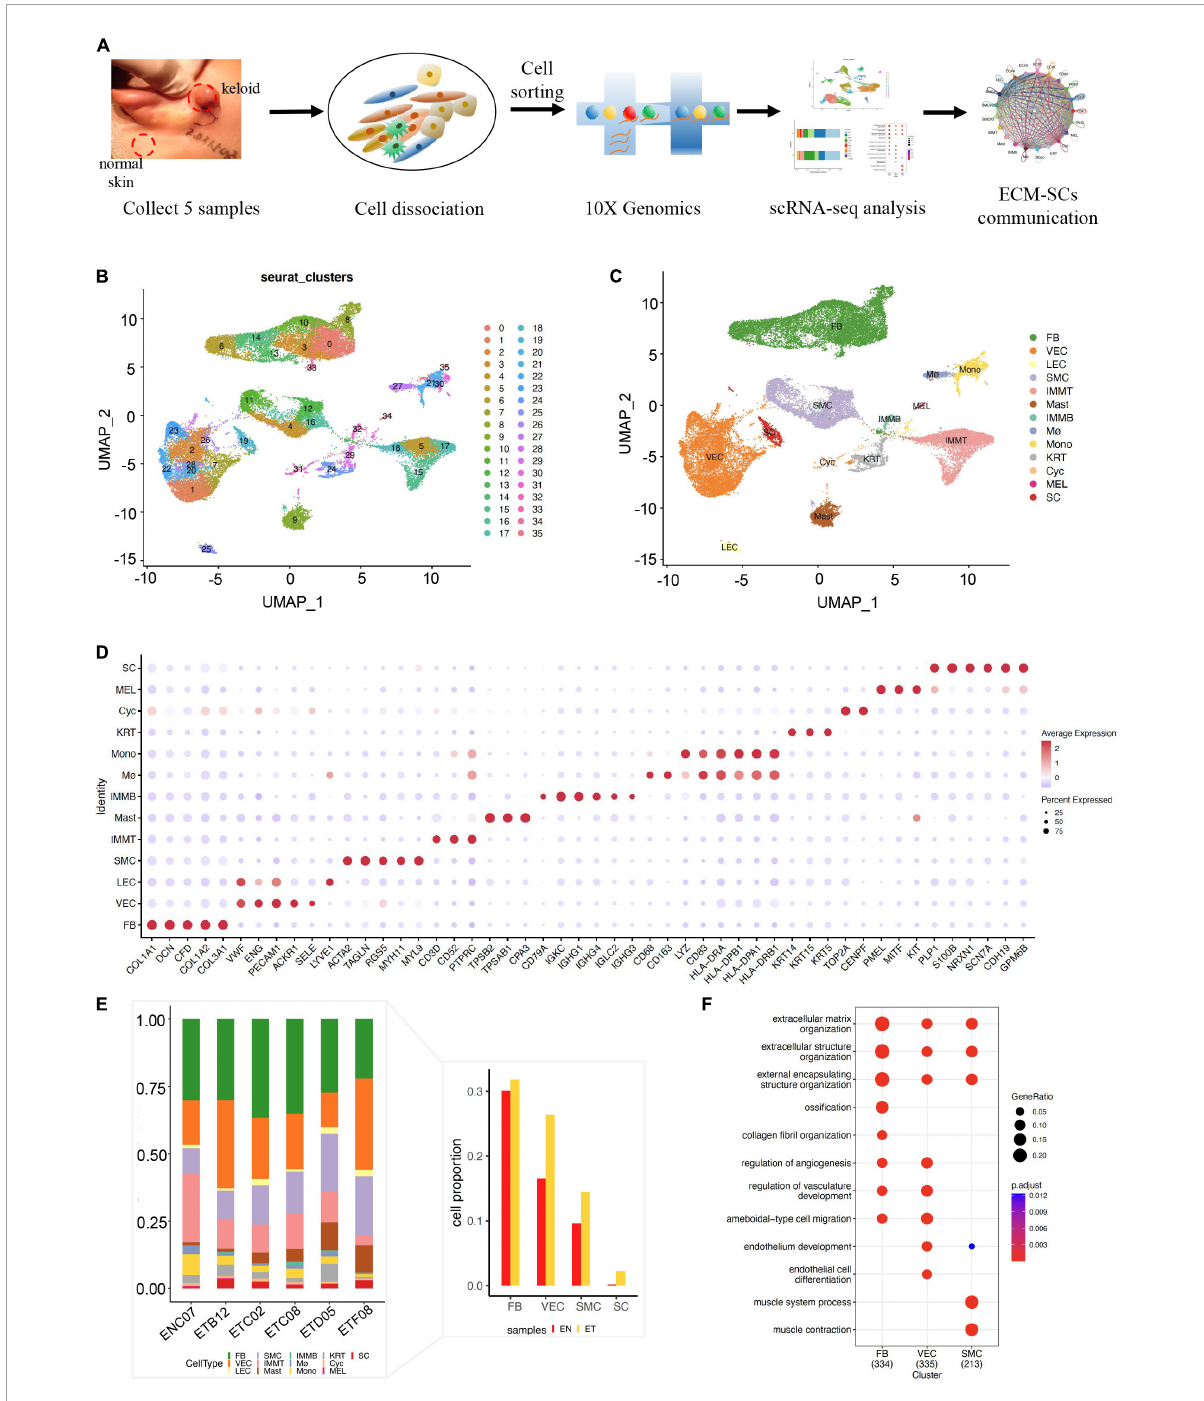
FIGURE1 Single-cell RNA-seq revealed the cell landscape of normal skin and earlobe keloid samples. (A) The workflow of scRNA-seq in human normal skin (EN) and earlobe keloid samples (ET). (B) All cells were merged and clustered by UMAP-clustering and were divided into 35 clusters. (C) All cells were annotated into 13 major cell types, including: fibroblast (FB), endothelial cell (EC), smooth muscle cell (SMC), T cell (IMMT), B cell (IMMB), monocyte (Mono), macrophage (Mø), mast cell (Mast), keratinocyte (KRT), cycling cell (Cyc), melanocytes (MELs), and Schwann cells (SCs). (D) Dot plot shows the classical markers of 13 major cell types. Dot size presents the proportion of cells within the group expressing each gene, and dot color is related to its expression level. (E) Bar plot showed the cell proportions of different cell types in each sample. The right bar plot showed the cell proportions of ECM-related populations and SC between normal skin sample (EN) and earlobe keloid samples (ET). (F) Gene ontology (GO) biological process enrichment analysis of upregulated genes in each ECM-related population (Wilcoxon rank-sum test, Bonferroni correction, log2 fold change (log2FC) cutoff of 0.25, and adjusted P -value of <